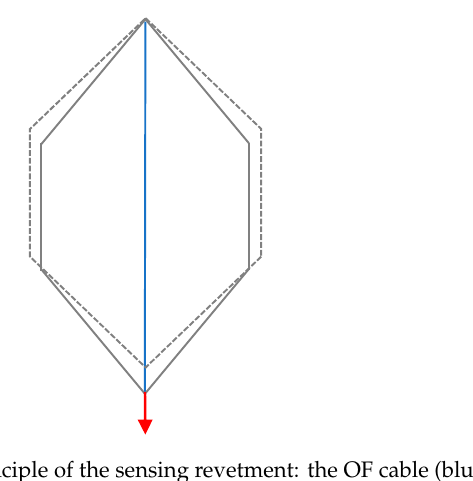
Figure 2. Sketch of the working principle of the sensing revetment: the OF cable (blue line) detects the closure of the meshes by deforming itself.